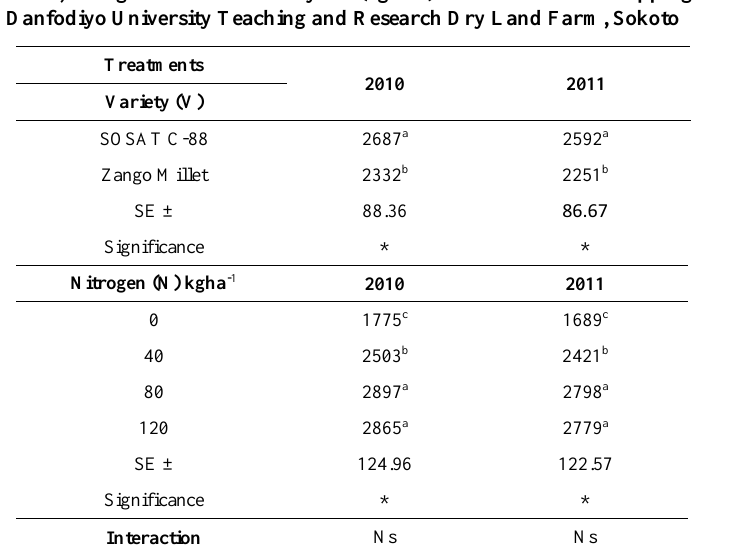
Table 8. Effect of varieties, nitrogen levels on Grain yield (kgha -1 ) in 2010 and 2011 cropping seasons at